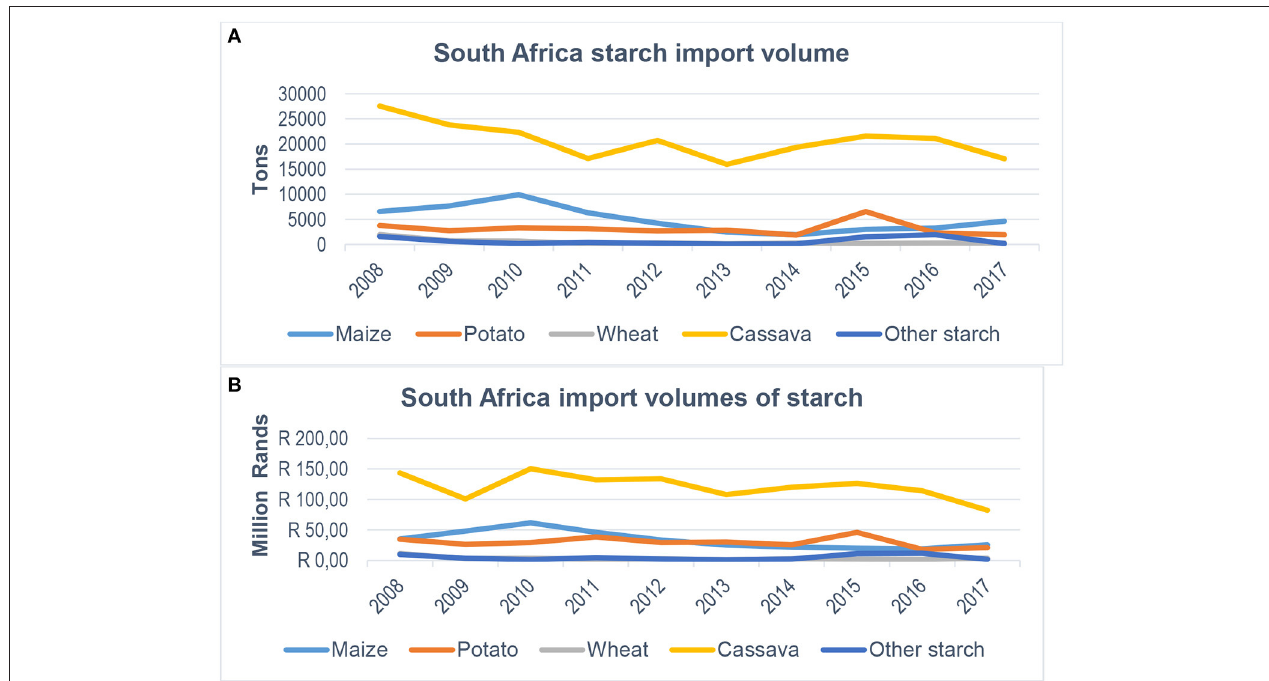
FIGURE 2 | (A) Starch import volumes into South Africa and (B) South Africa’s import volumes of various starches (Source: Commodity Trade Statistics Database, United Nations Statistics Division,